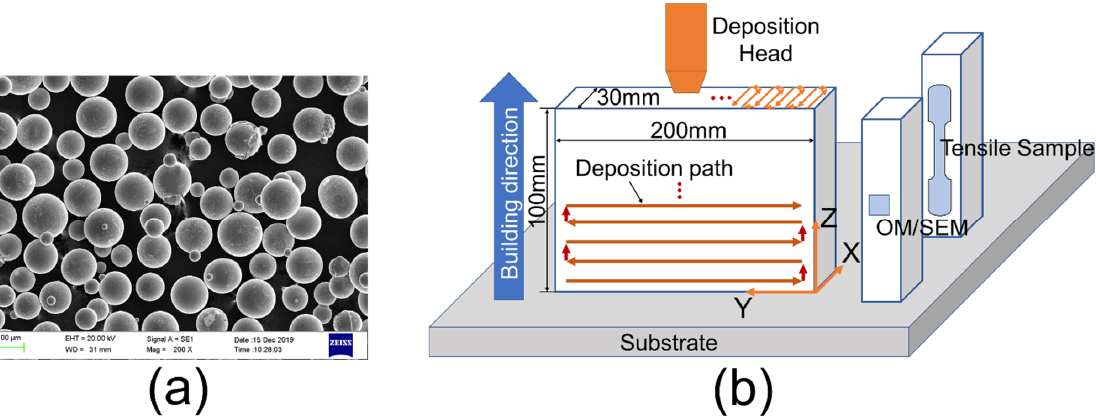
Figure 1. ( a ) The SEM of the TC 31 alloy powder and ( b ) the sample orientation and deposition